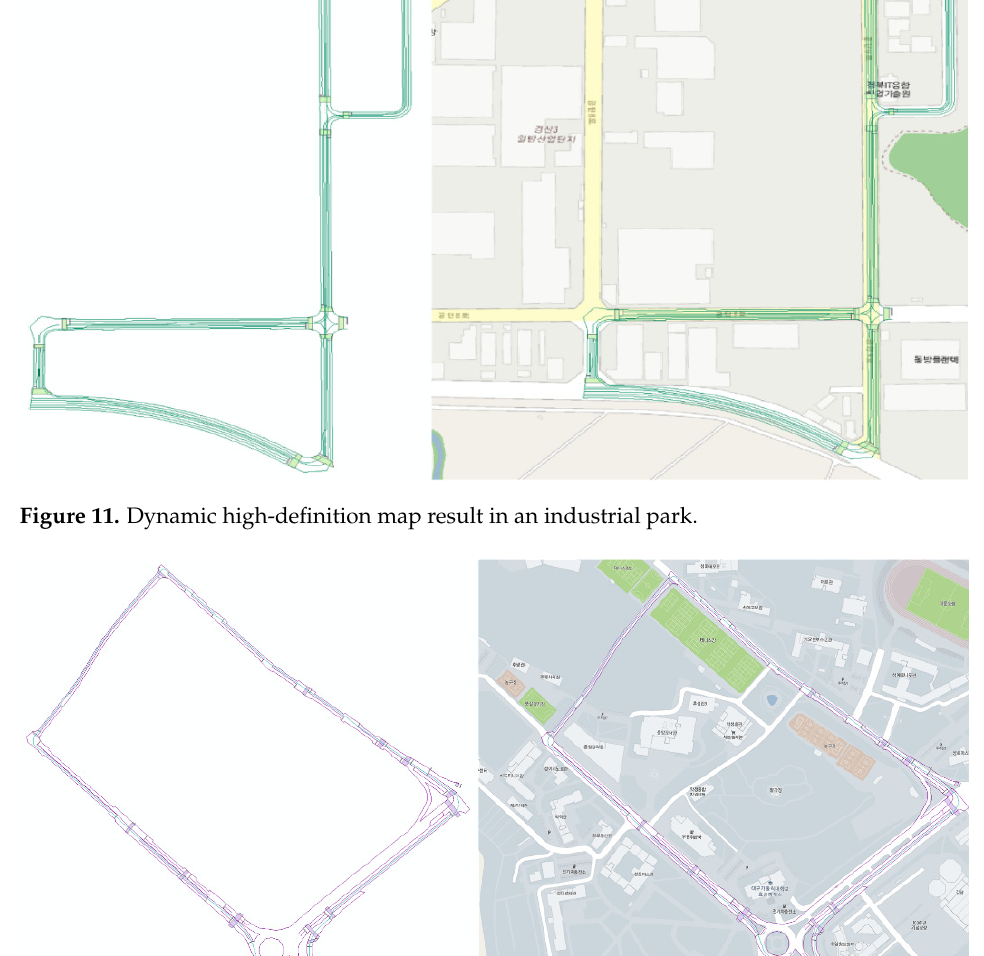
Figure 13. Dynamic high-definition map result at a residential complex.